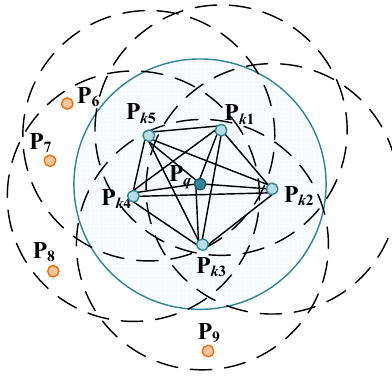
Figure 10. The FPFH feature diagram.